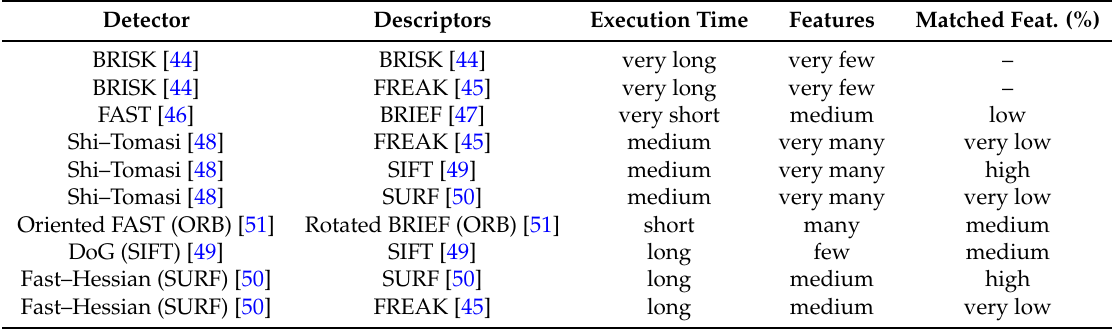
Table 1. Comparison of feature detectors and descriptors in the long-wavelength infrared radiation (LWIR)